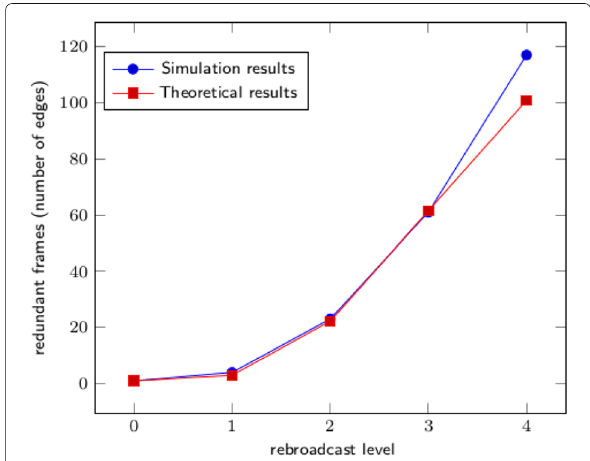
Fig. 10 Redundant rebroadcast frames with rebroadcast levels in simple flooding for a sample 20-node network